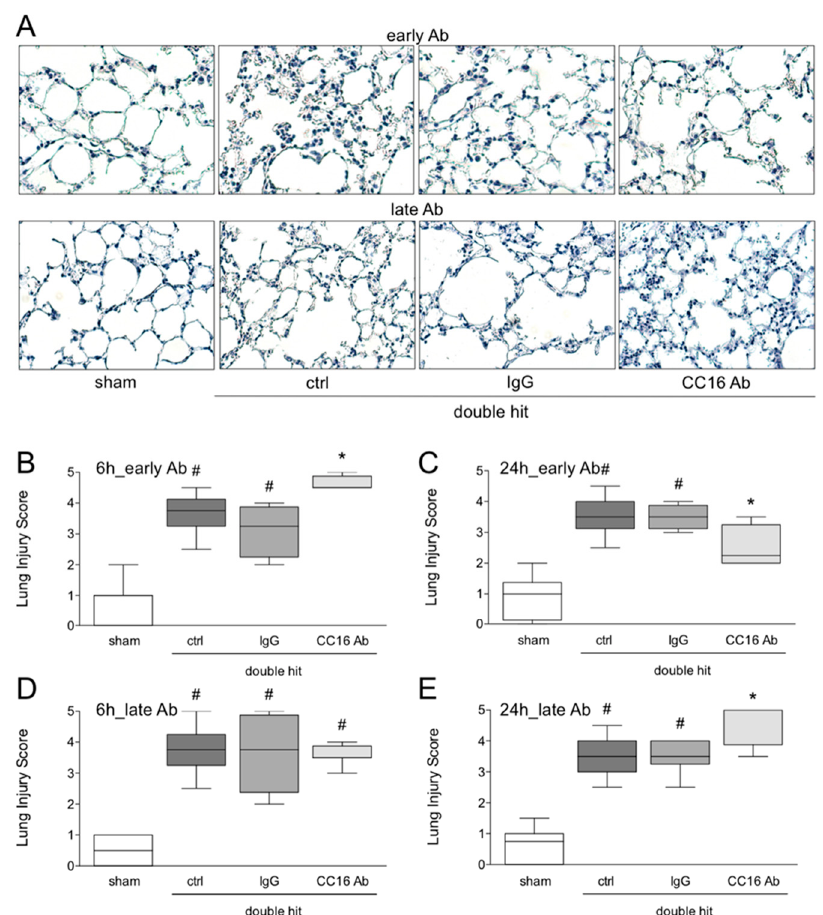
Figure 6. Representative lung sections after hematoxylin-eosin staining are shown ( A ). Lung injury was quantified as lung injury score ( B – E ). Interventions with either CC16 antibody (Ab) or IgG control (IgG) antibody were performed either early (post TxT, upper line of (A), and (B,C)) or late (post-CLP, lower line of (A) and (D–E)) to the lungs. Six or 24 hours later, the animals were euthanized for sampling. *: p < 0.05 versus all; #: p < 0.05 versus sham, n = 8.